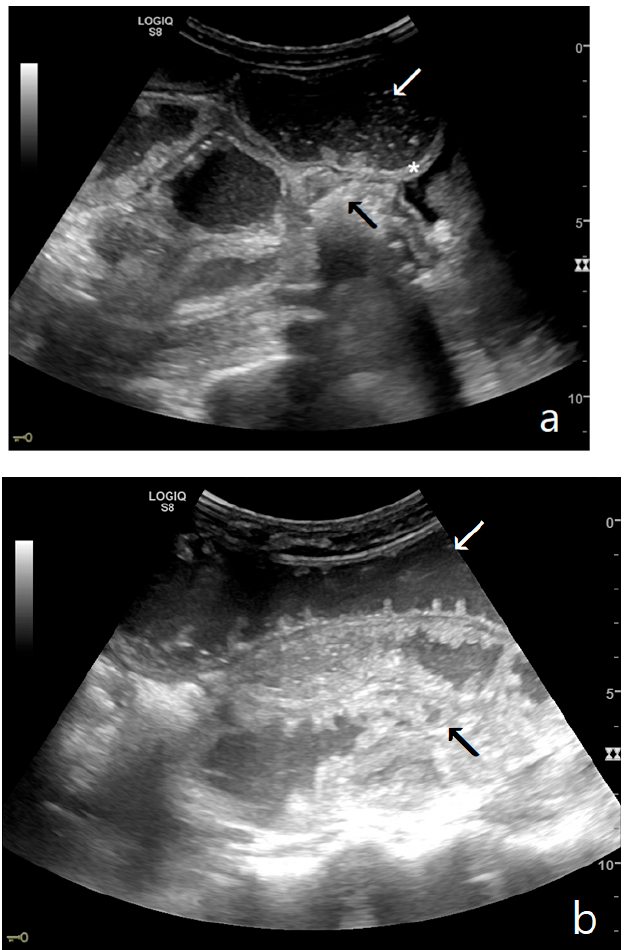
Figure 3. A decompensated SBO, presenting fluid-filled, dilated small bowel loops with increased parietal thickening (*) ( a ) and free fluid between bowel loops ( a ). ‘Caliber jump’: a difference in caliber between the swollen loops upstream (white arrows) ( a , b ) and the collapsed loops downstream of the obstruction (black arrows) ( a , b ).